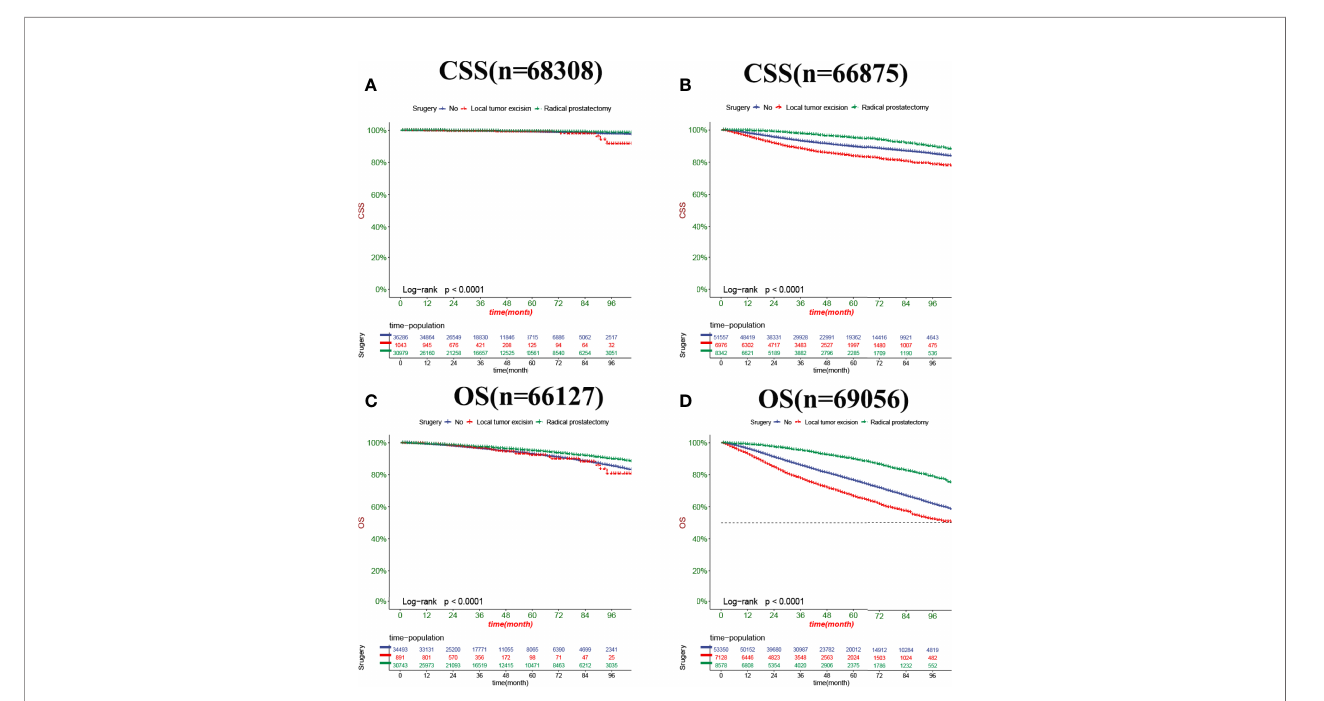
FIGURE 7 | Kaplan-Meier curves of patients with a different surgery. (A) The CSS rate of patients in the low-risk group underwent different surgery. (B) The CSS rate of patients in the high-risk group underwent different surgery. (C) The OS rate of patients in the low-risk group underwent different surgery. (D) The OS rate of patients in the high-risk group underwent different